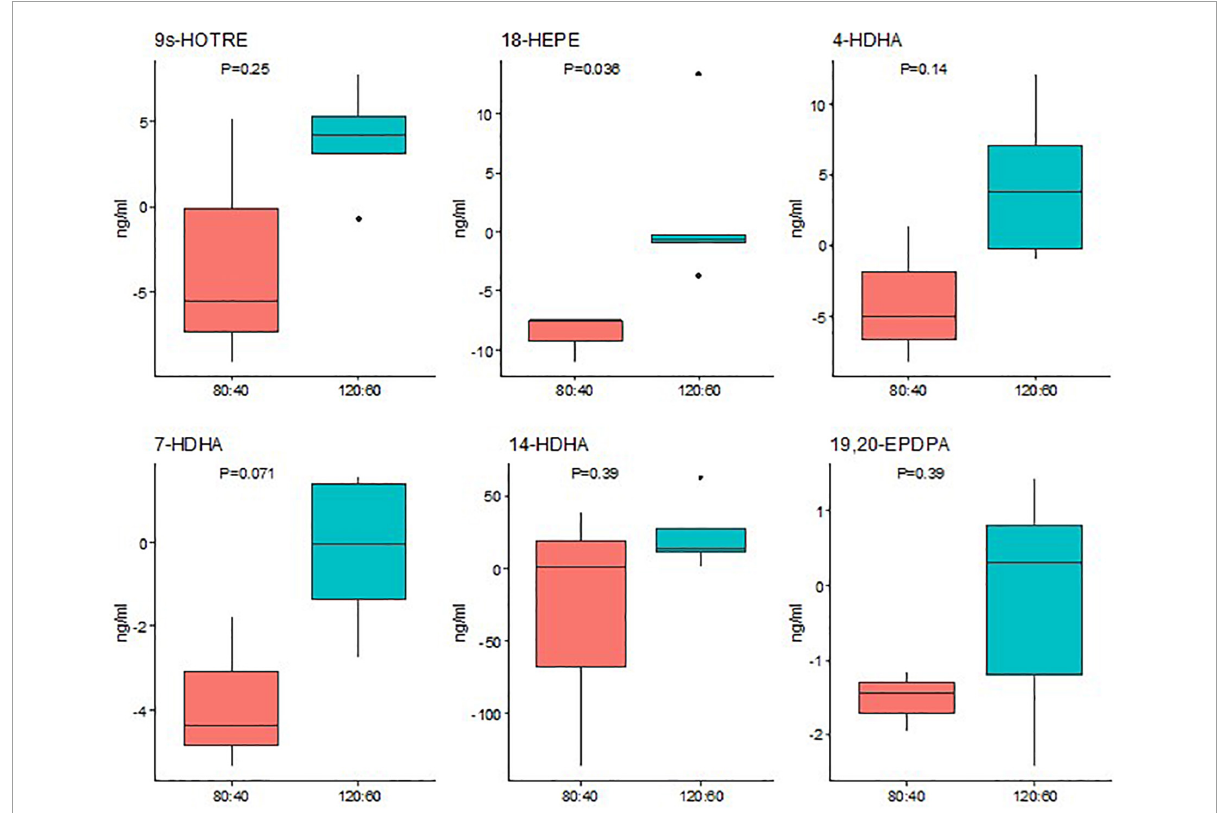
FIGURE3 Changes in whole blood oxylipins derived from omega-3 LCPUFAs from birth to 36 weeks’ postmenstrual age according to ARA:DHA group supplementation. Data show median and interquartile range [Q1; Q3]. The p -value was extracted from Mann–Whitney